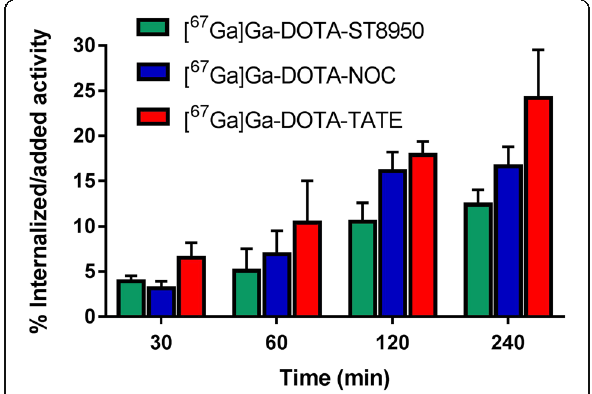
Fig. 2 Internalization of the 67 Ga-labeled conjugates in HEK-SST2 cells over time, expressed as % (mean ± SD) of applied activity in the cells and normalized per million cells. All values refer to specific internalization after subtracting the non-specific (measured in the presence of 1000-fold excess of SS-14) from the total internalized fraction, at each time